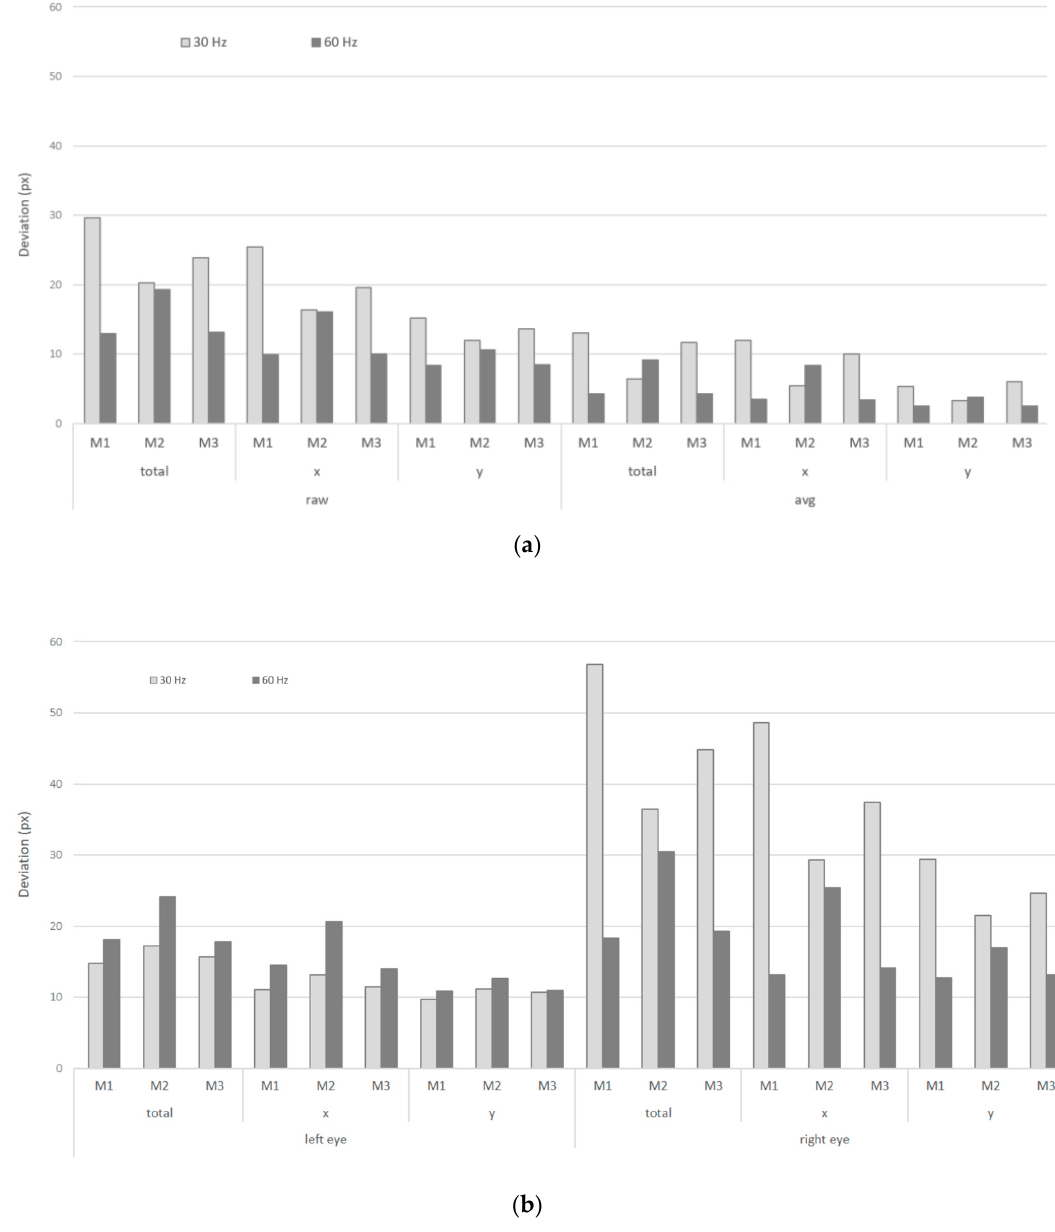
Figure 5. Deviations (px) for the artificial participants (AP) computed for the default resolutions of M1, M2, and M3 for both 30 Hz and 60 Hz set-ups; raw versus avg data ( a ) and left versus right eye ( b ). The obtained deviations are recalculated in terms of visual angle, which is dependent on the viewing distance. Besides the 60 cm distance that was employed during the experiment, deviations corresponding to three other (theoretical) viewing distances are calculated as well—50 cm, 55 cm, and 65 cm. The results can be found in Figure 6, with a distinction between the 30 Hz and 60 Hz recordings for M1 at different resolutions.